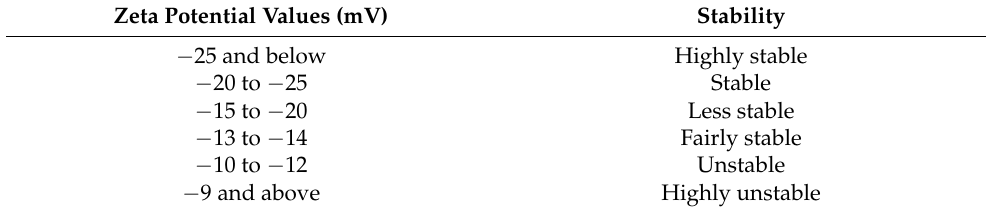
Table 4. Stability indicator